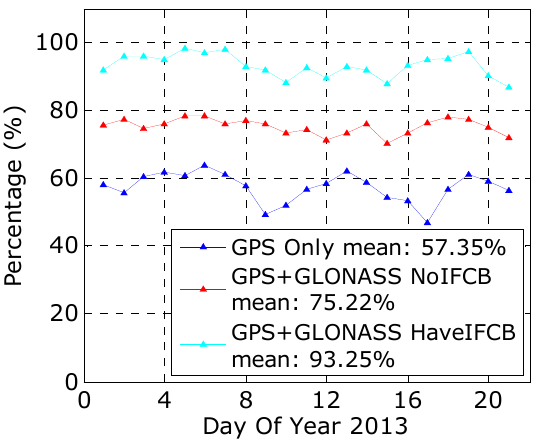
Figure 17. Fixing percentage for kinematic PPP with different strategies for observation duration 15 min on each day.